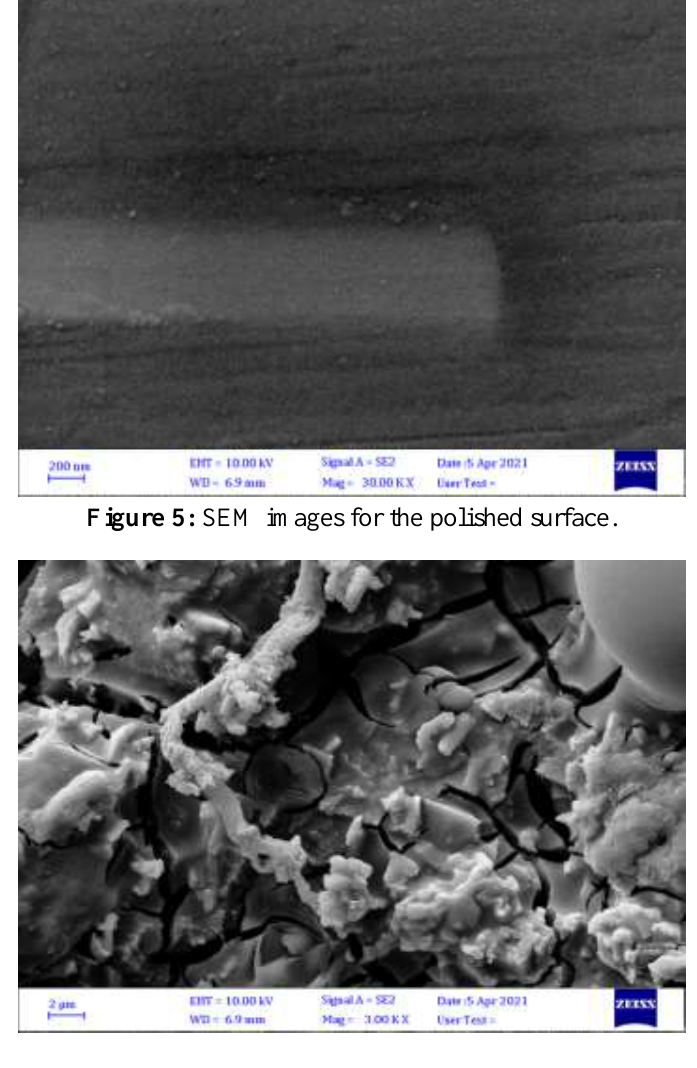
Figure 6: SEM images after corrosion in HCl